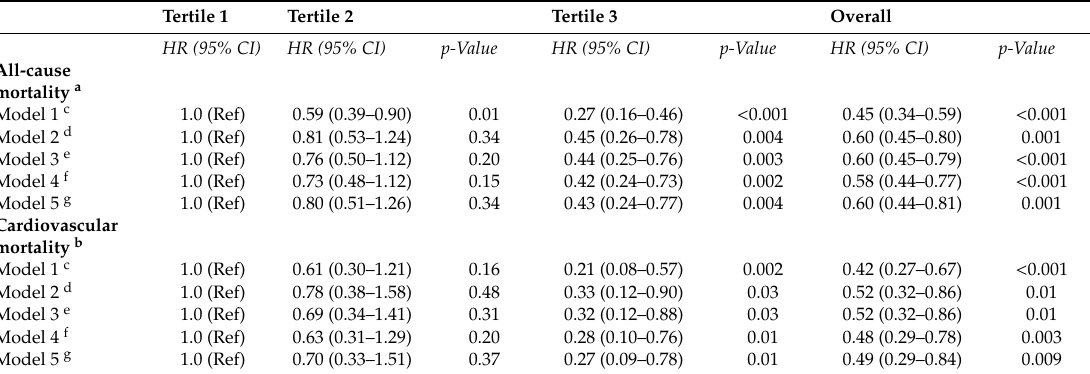
Table 4. Cox proportional hazards regression analysis for the association of 6-sulfatoxymelatonin with all-cause and cardiovascular mortality in RTRs (without diabetic nephropathy)